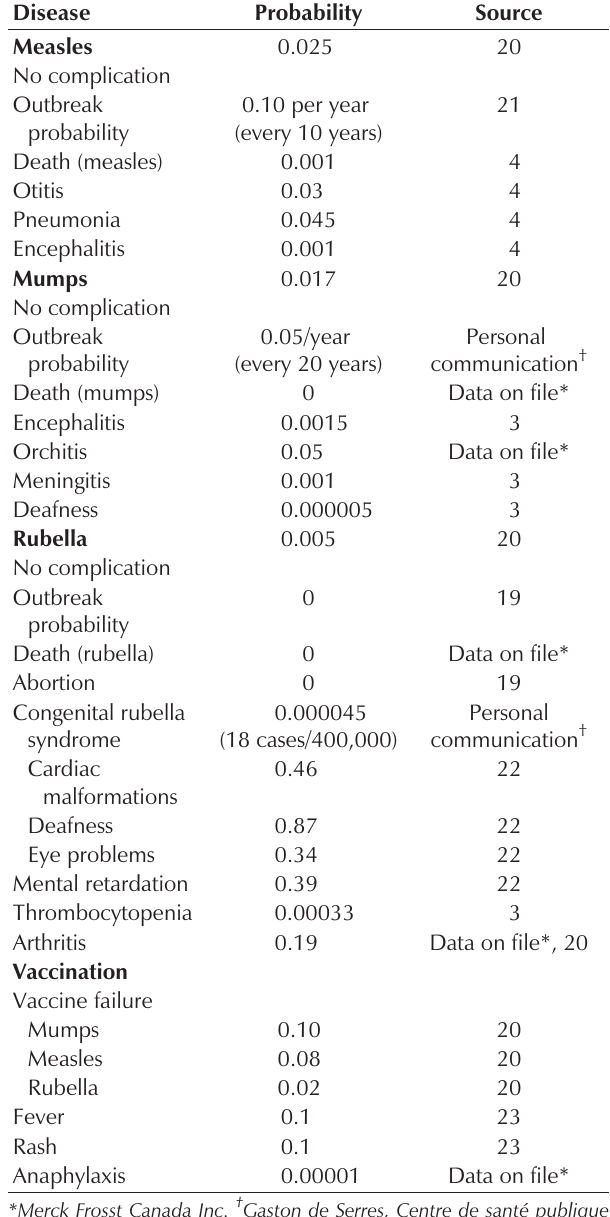
Probabilities and sources Disease